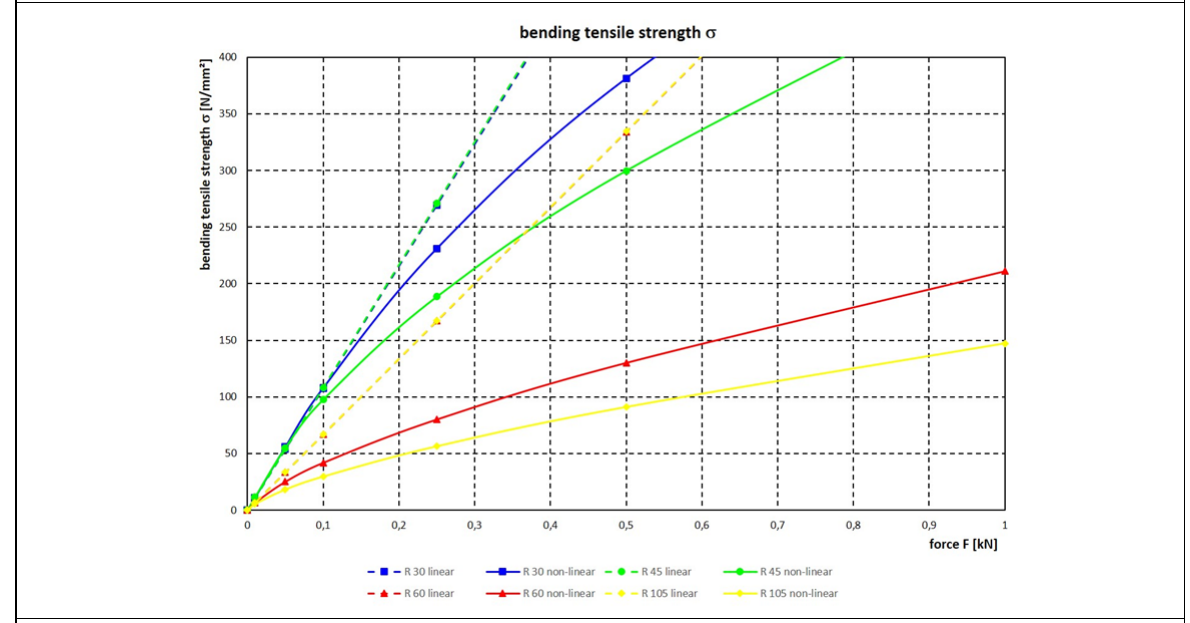
Fig. 11 Diagram - bending tensile strength  /force F